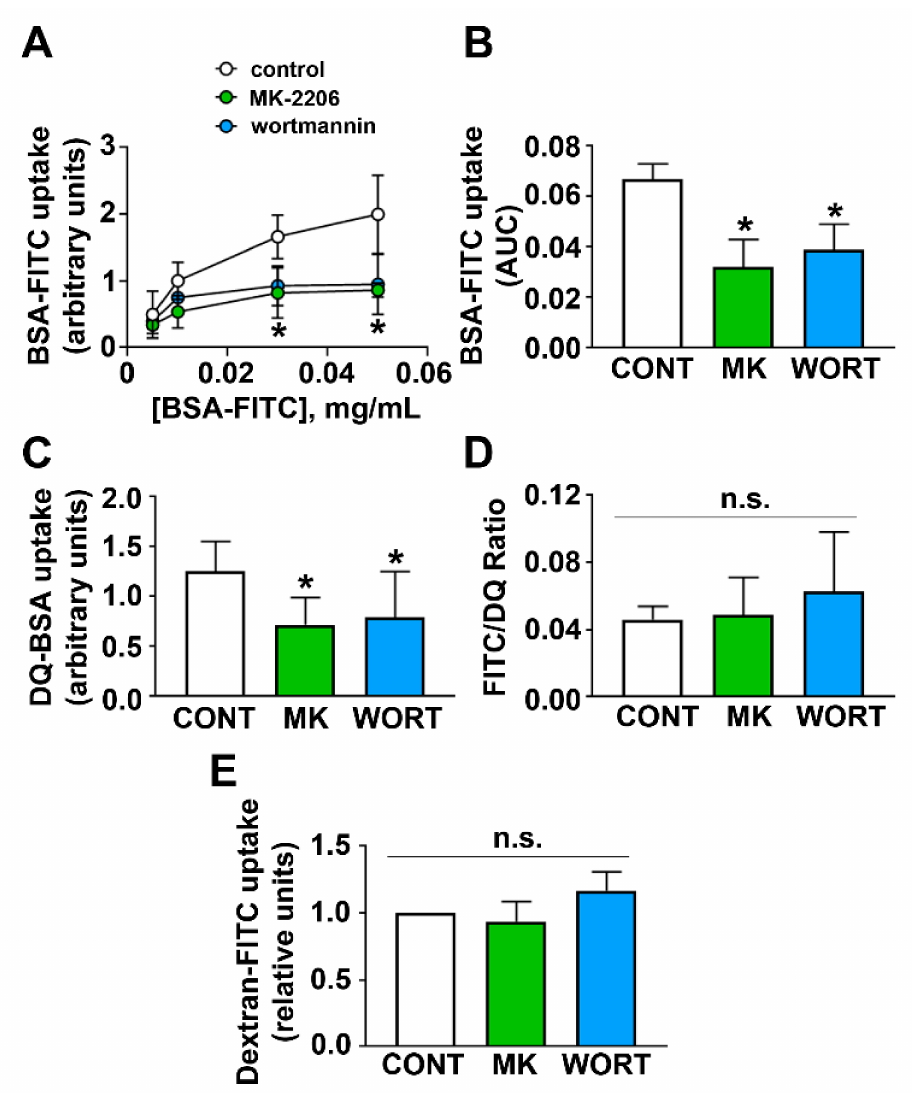
Figure 1. PI3K/AKT inhibition reduces the albumin endocytic capacity of PTECs. ( A ) Dose–response curve of BSA-FITC on BSA-FITC uptake was evaluated in LLC-PK1 cells pre-treated for 1 h with MK-2206 10 µ M (MK) or wortmannin 1 µ M (WORT) or not (control condition; CONT) (n = 3). ( B ) Area under the curve (AUC) was calculated from the data shown in ( A ). ( C ) DQ-BSA lysosomal degradation (n = 3) and ( D ) dextran-FITC uptake (n = 3) were evaluated under the same experimental conditions described above. ( E ) Ratio between BSA-FITC and DQ-BSA uptake expressed as % of the control. Data are presented as means ± standard deviation. * p < 0.05 versus control. One-way ANOVA with Tukey’s multiple comparisons test was used. n.s., no